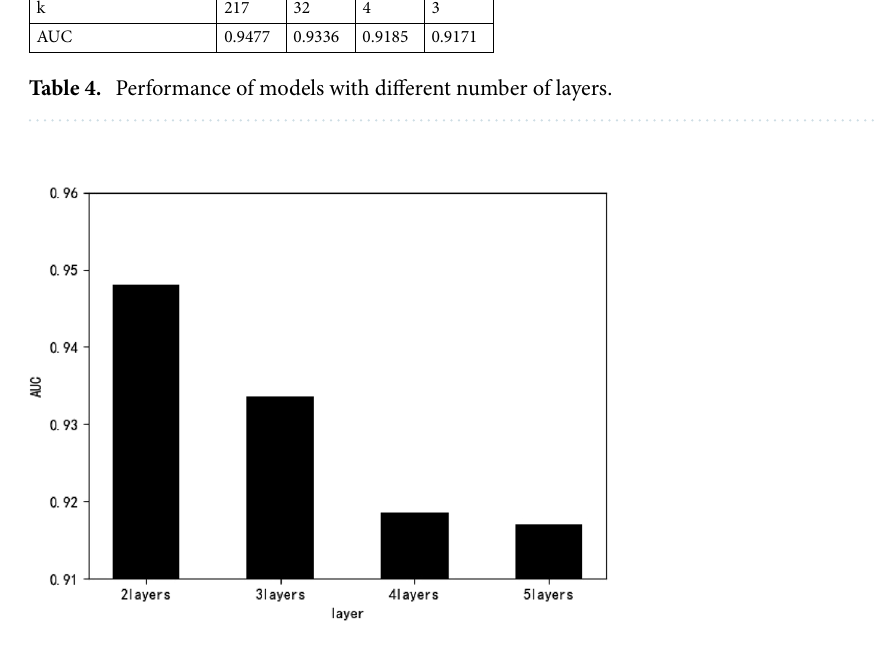
Figure 5. Performance comparison of different layer